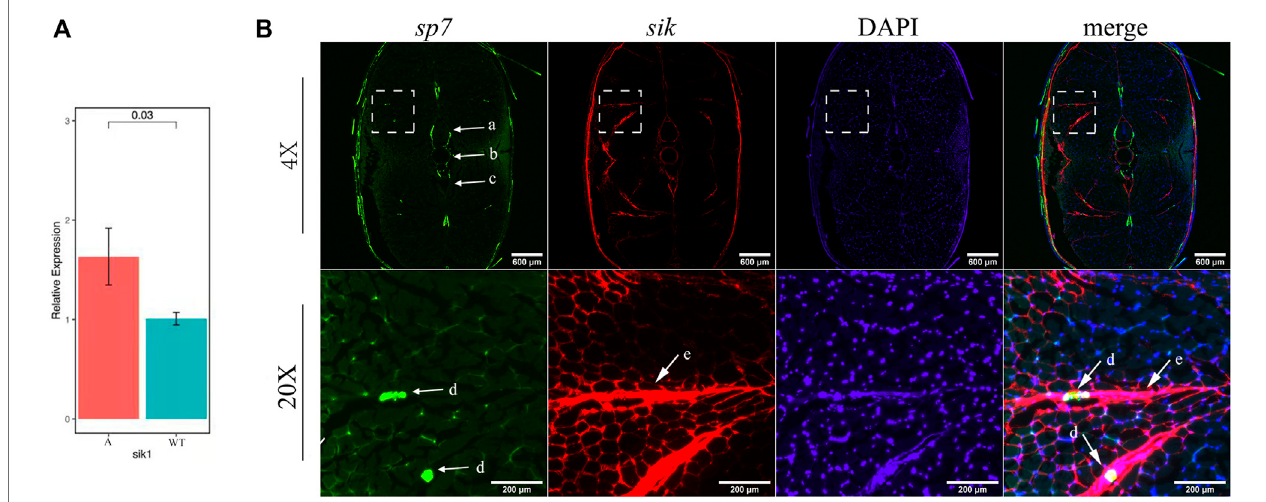
FIGURE 8 | qRT-PCR and RNA-FISH of sik1. (A) Expression level of sik1 in group A and wild-type. (B) Sik1 expressed in the myospetum surrounding IBs and the mRNA of sik1 was detected with Alexa Fluor 647 fl uorescent probes. a: neural arches; b: vertebrae; c: hemal arches; d: IBs; and e: myoseptum